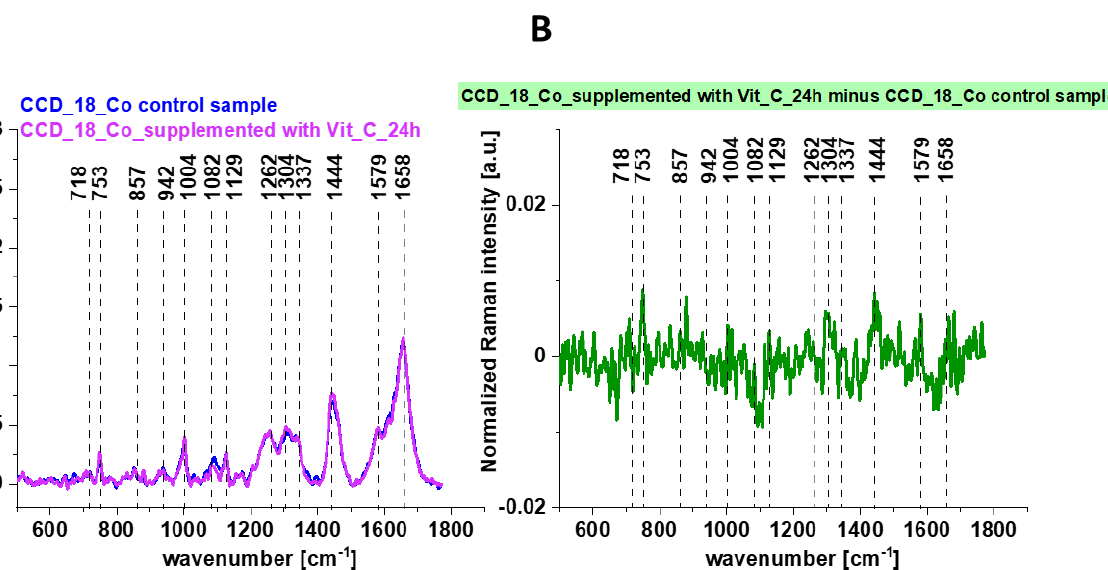
Figure 9. The average Raman spectra obtained for CCD-18 Co human normal colon cells in oxidative stress condition, the average Raman spectra typical for CCD-18 Co human normal colon cells supplemented with vitamin C and tBuOOH for 24 h ( A ) and the differential Raman spectrum ( B ) calculated based on spectra presented on panel (A); excitation laser line 532 nm, number of cells=6 for each type.